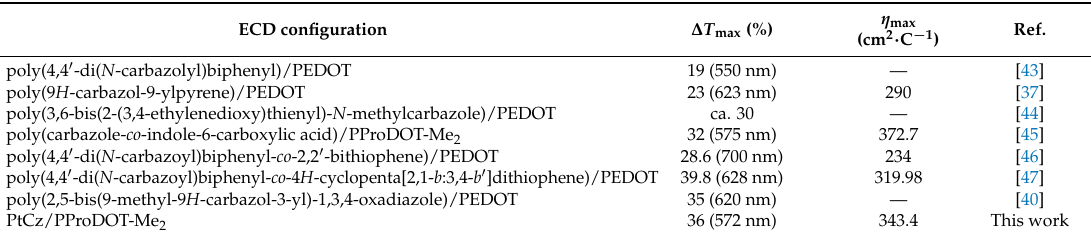
Table 6. Optical contrast and coloration efficiencies of